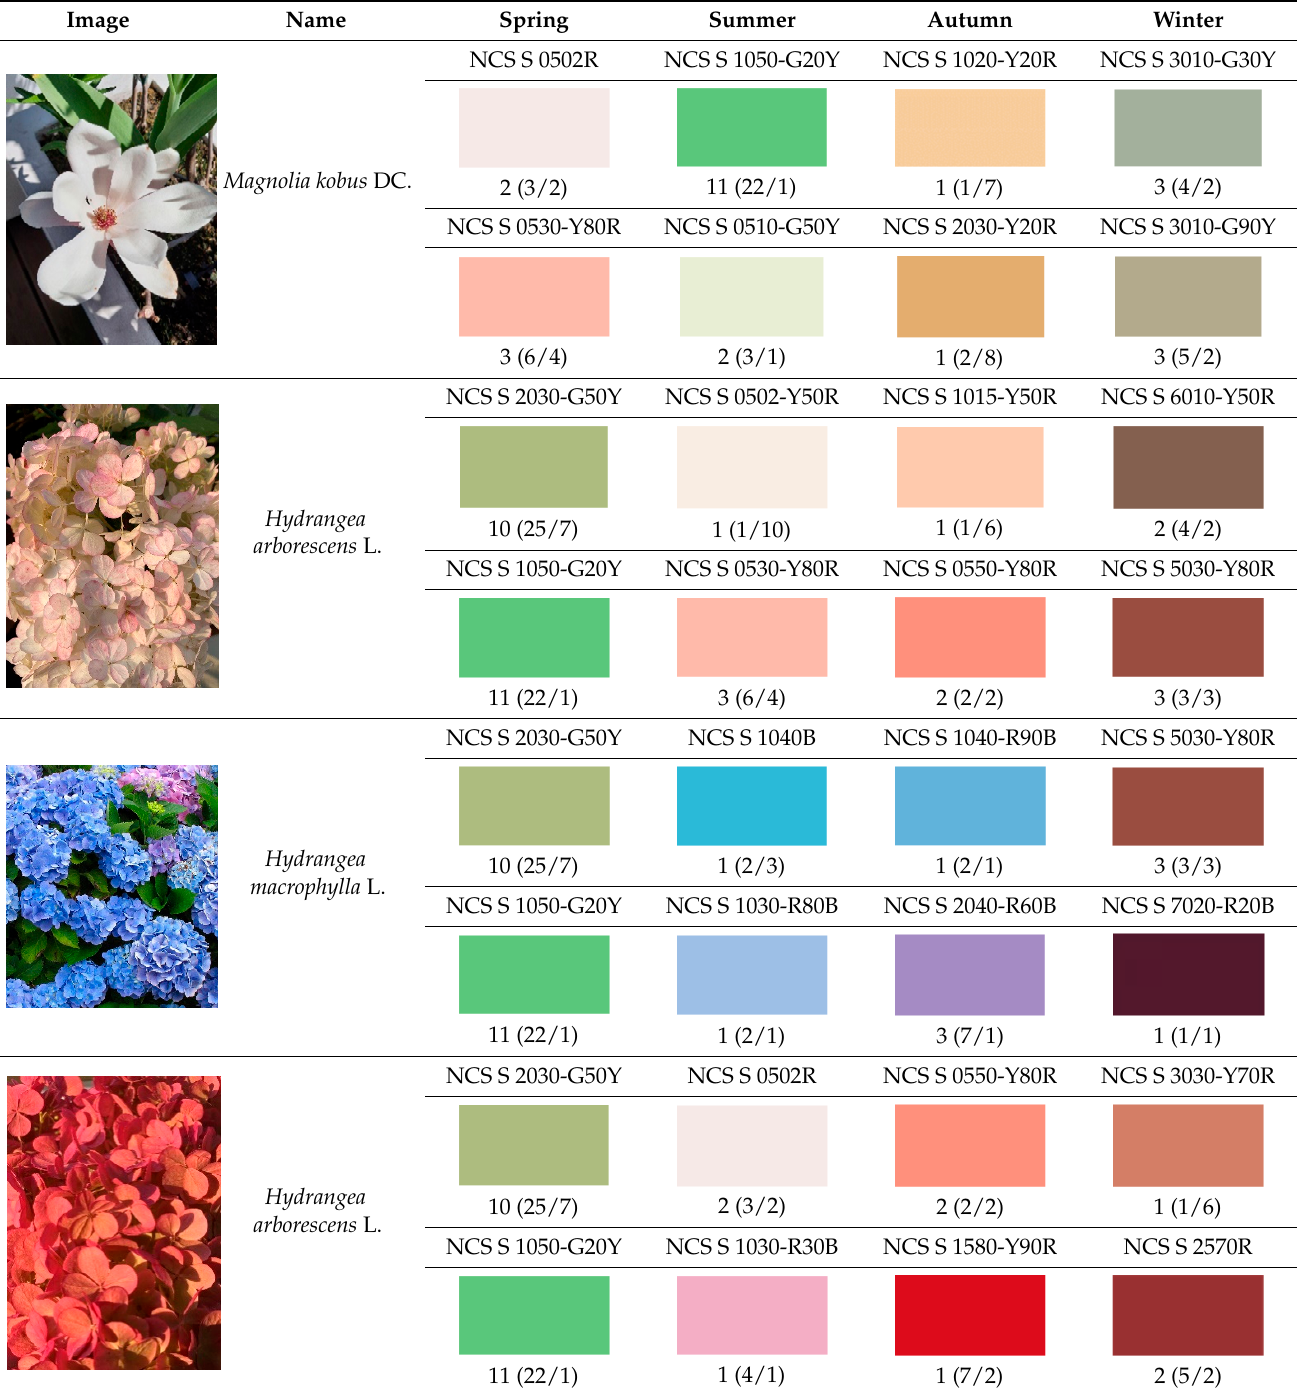
Table A3. One hundred and twenty-three color samples taken from the blooming plants identified in the research area. The numbers below the color sample provide the information how many times a given color appears in the table (how many times it appears in all natural samples/how many times it appears in the analyzed architectural objects).